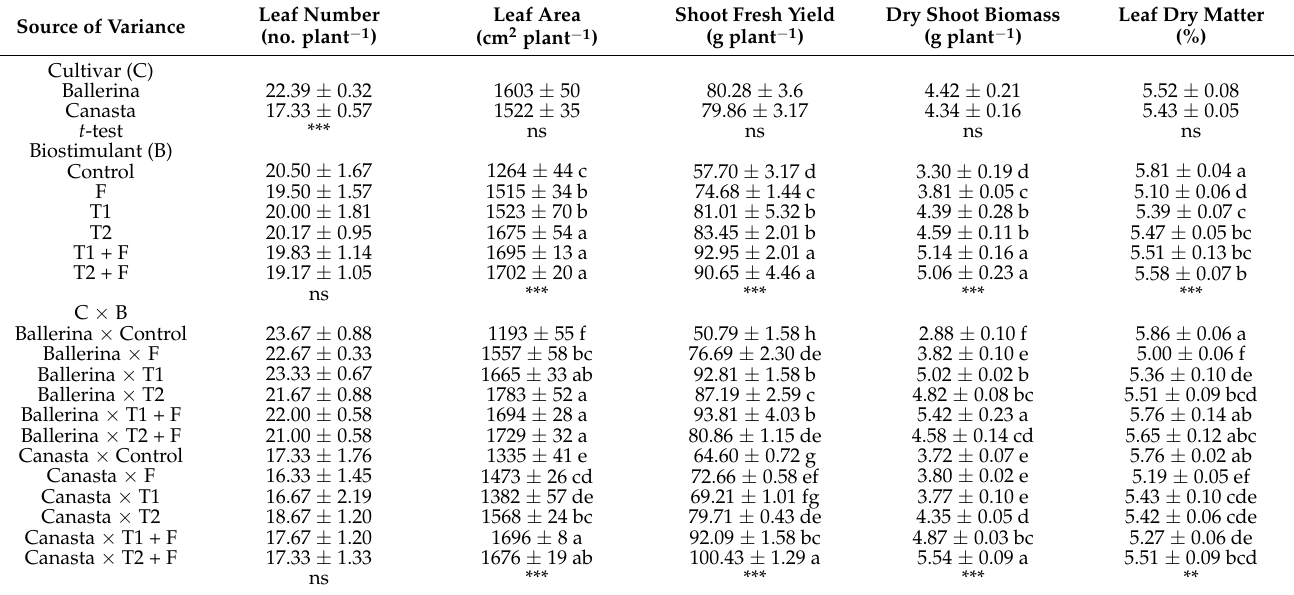
Table 1. Leaf number, leaf area, fresh and dry biomass and leaf dry matter of ‘Canasta’ and ‘Ballerina’ lettuce as influenced by the biostimulant